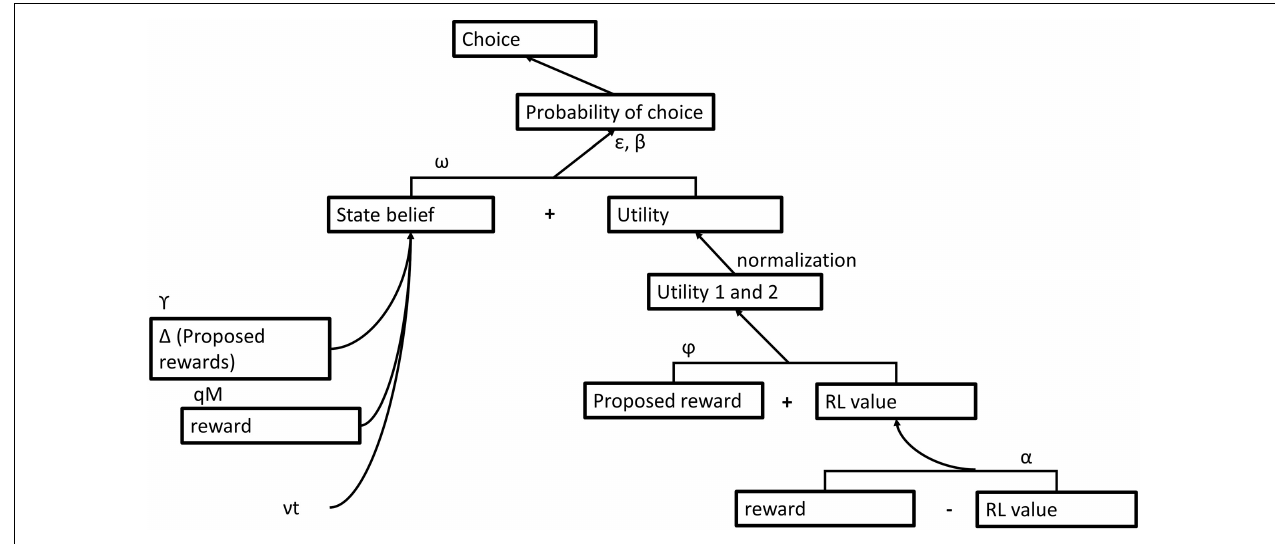
FIGURE 3 | Scheme of the computational algorithm of the MIX